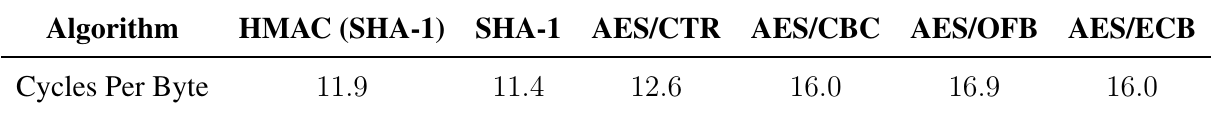
Table 4. A result of Crypto++ benchmarks for HMAC, SHA-1 and